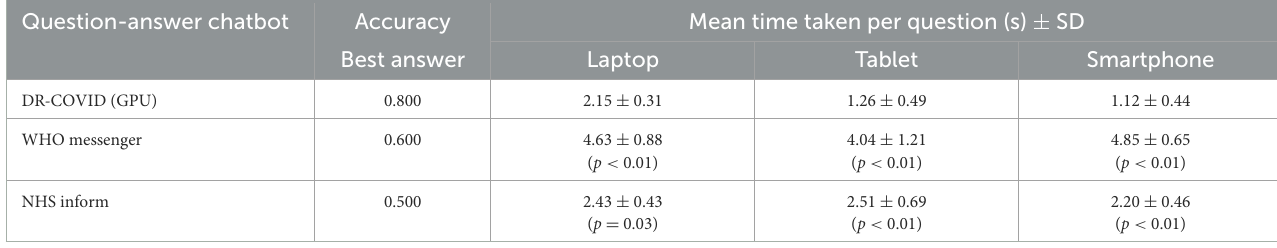
TABLE 3 Accuracy and user interface assessment for DR-COVID and other enterprise-grade chatbot systems, across three digital devices. Question-answer